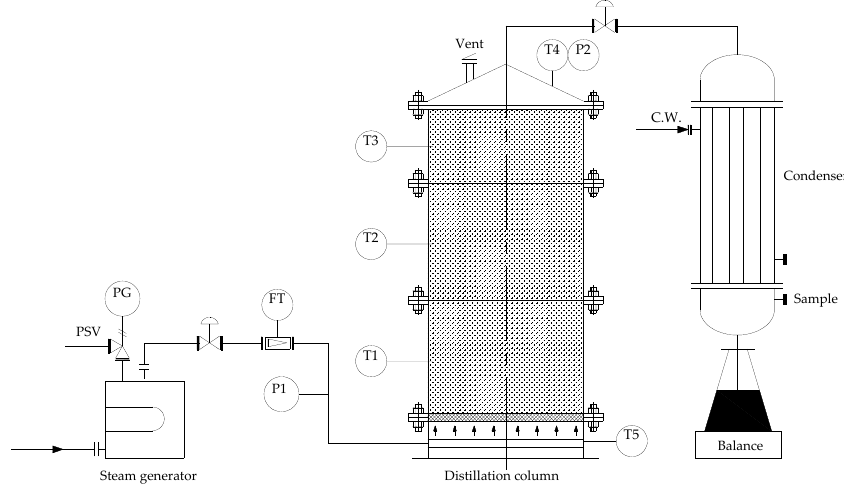
Figure 1. Experiment apparatus and solid-state distillation flowsheet.